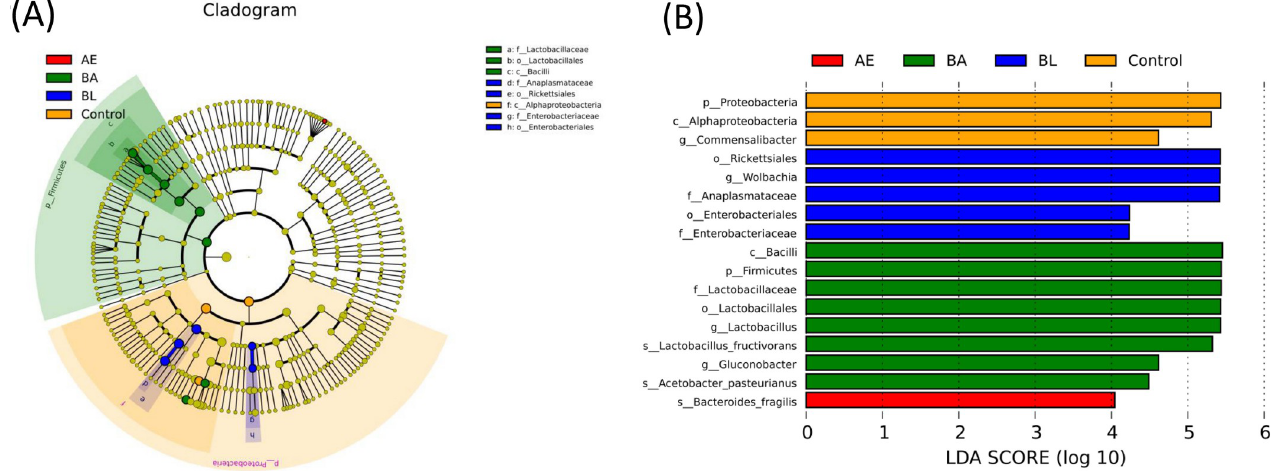
Fig 7. Cladogram (A) and linear discriminant analysis (LDA, B) scores of the InR [E19] /TM2 D . melanogaster on the AE, BL, BA-supplemented diet and the standard (Control) diet. AE: Astragalus membranaceus extract, BL: Bacillus licheniformis and BA: Bacillus . licheniformis and Astragalus membranaceus extract.